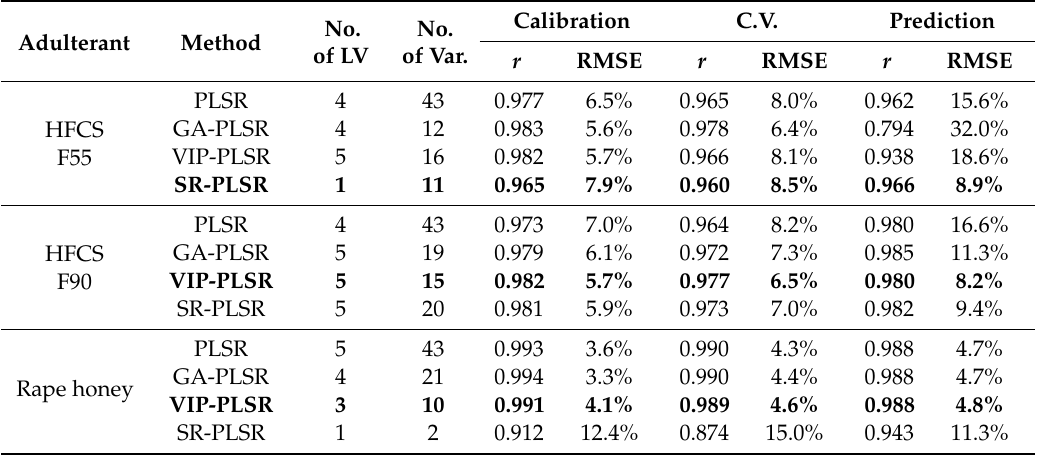
Table 2. Multivariate analysis results based on partial least square regression (PLSR) and feature selection